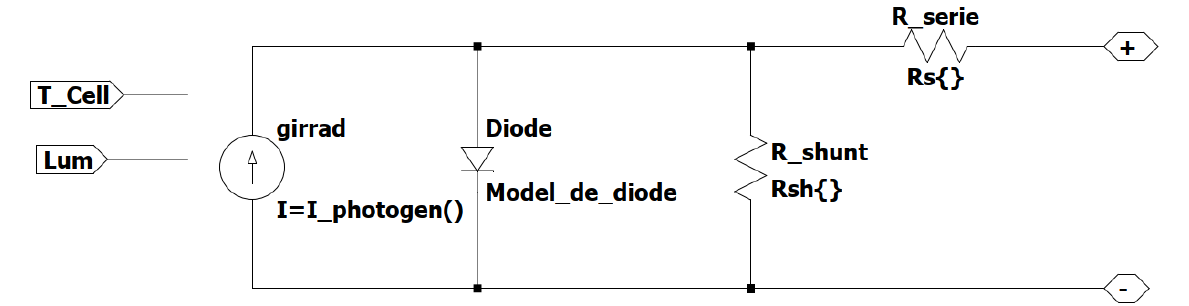
Figure 3 . Behavioral model of a photovoltaic cell under